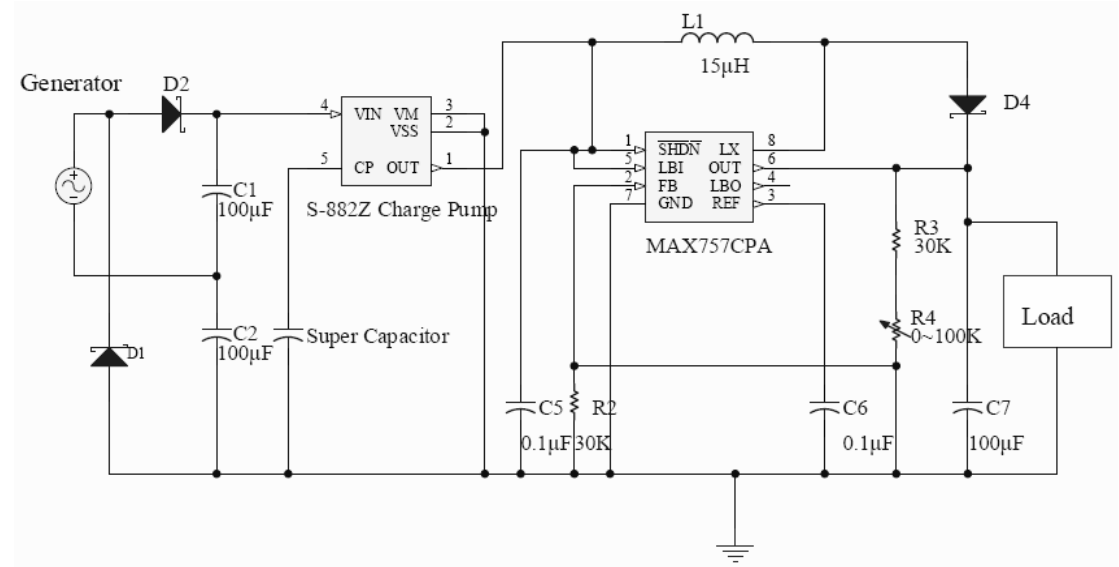
Figure 12. Schematic diagram of power management